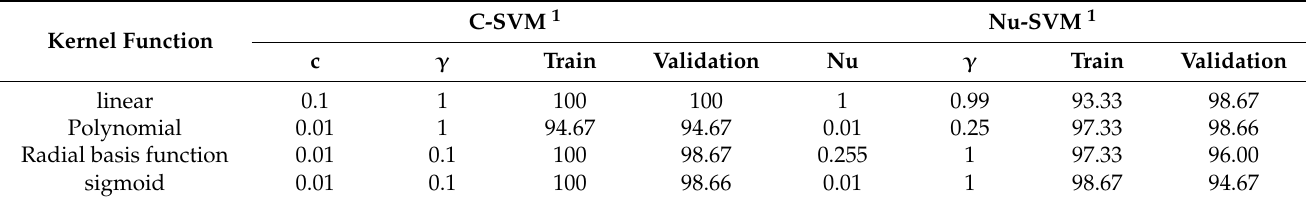
Table 4. Results and comparison of Nu-SVM and C-SVM models subjected to the kernel functions.